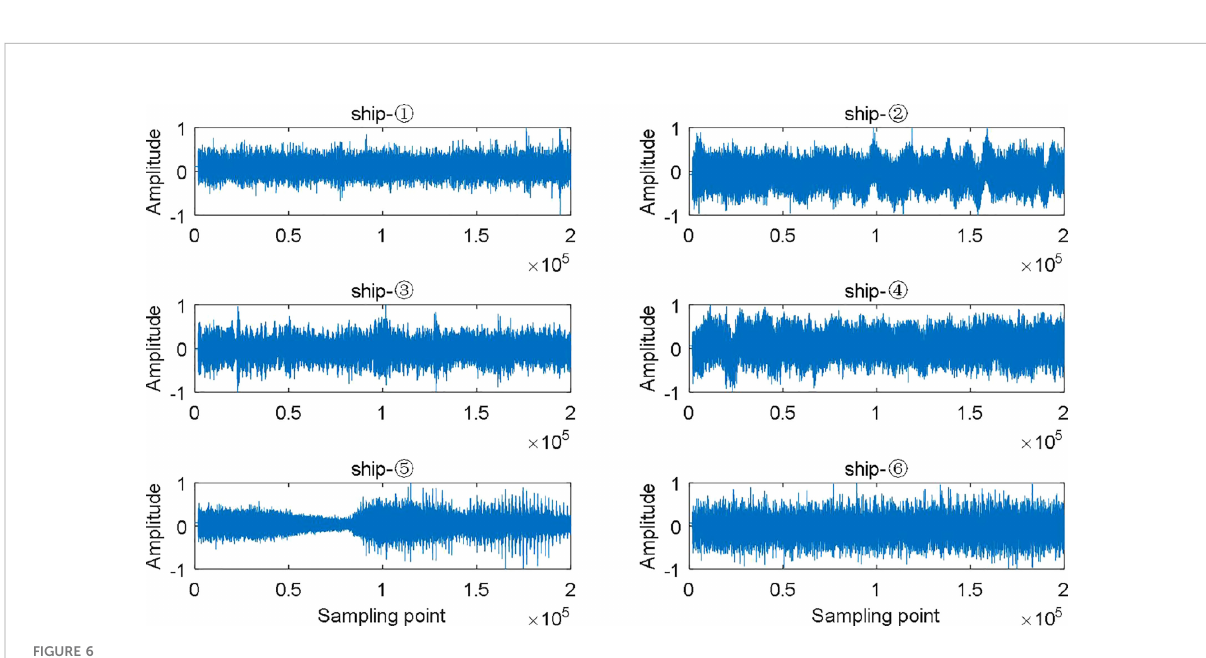
FIGURE 6 The normalized results of six types of